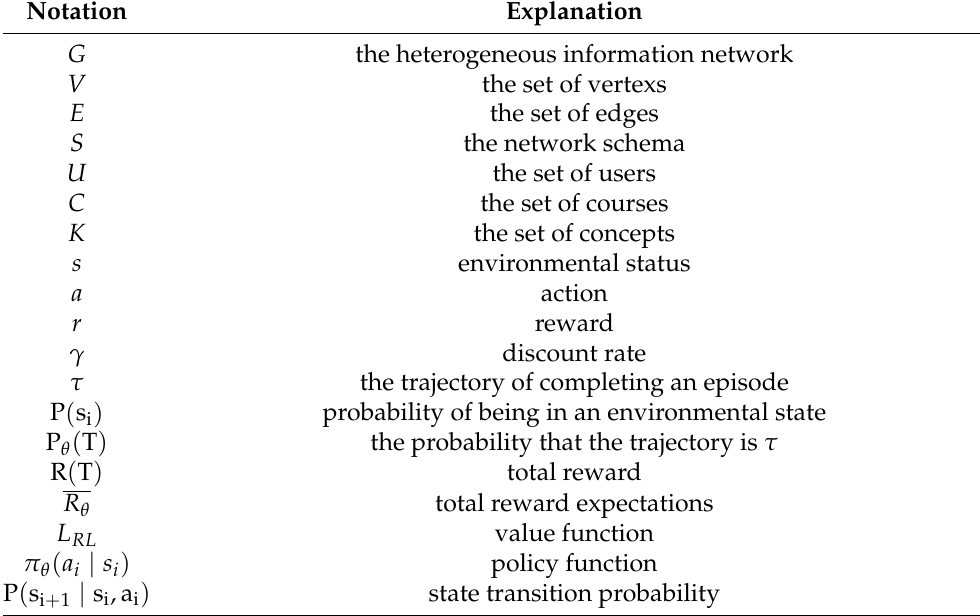
Table 1. Notations and